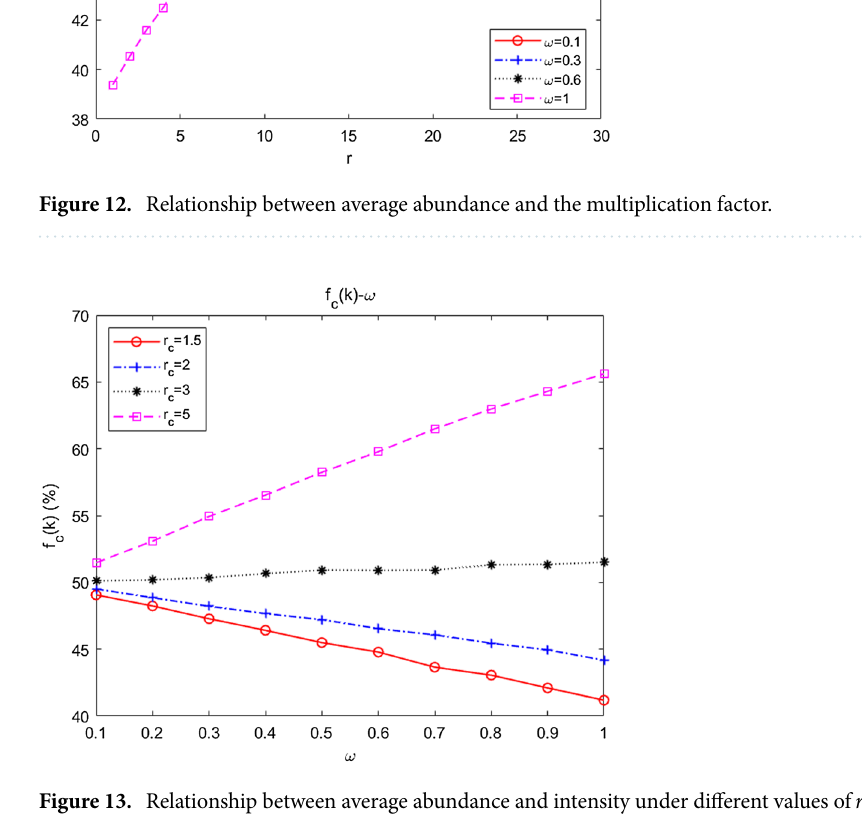
Figure 13. Relationship between average abundance and intensity under different values of r C